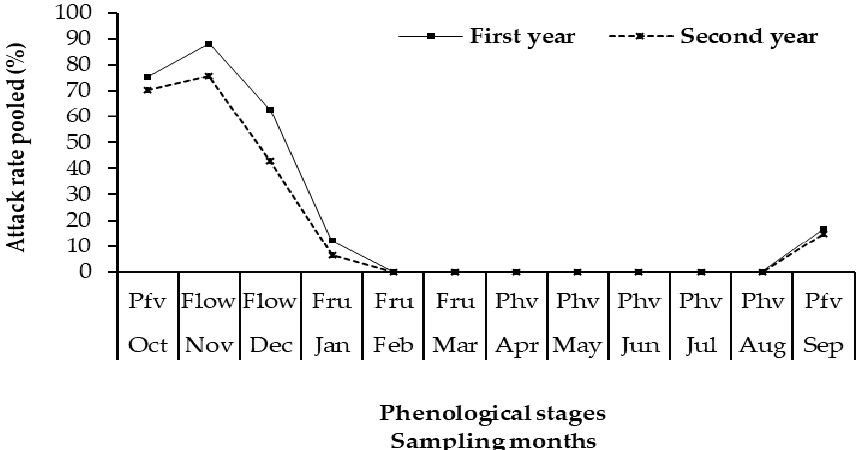
Figure 5. Relationship between attack of D. trifasciata and cashew tree phenological stages per year; First year: October 2015–September 2016; Second year: October 2016–September 2017. Pre-flowering vegetative growth stage = Pfv; Flowering stage = Flow; Fruiting = Fruc; Post-harvest vegetative growth stage (Phv).